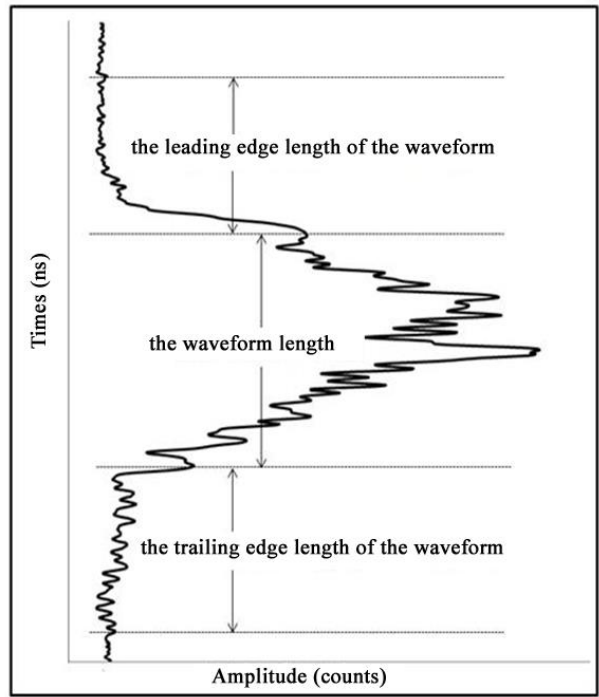
Figure 3. Main characteristics of the GLAS waveform data.